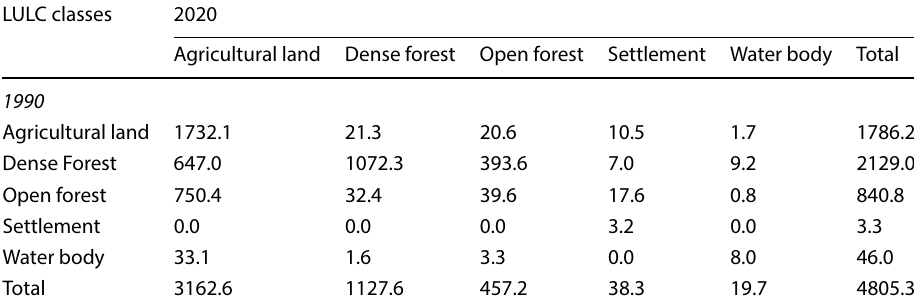
Table 4 LULC conversion from 1990 to 2020